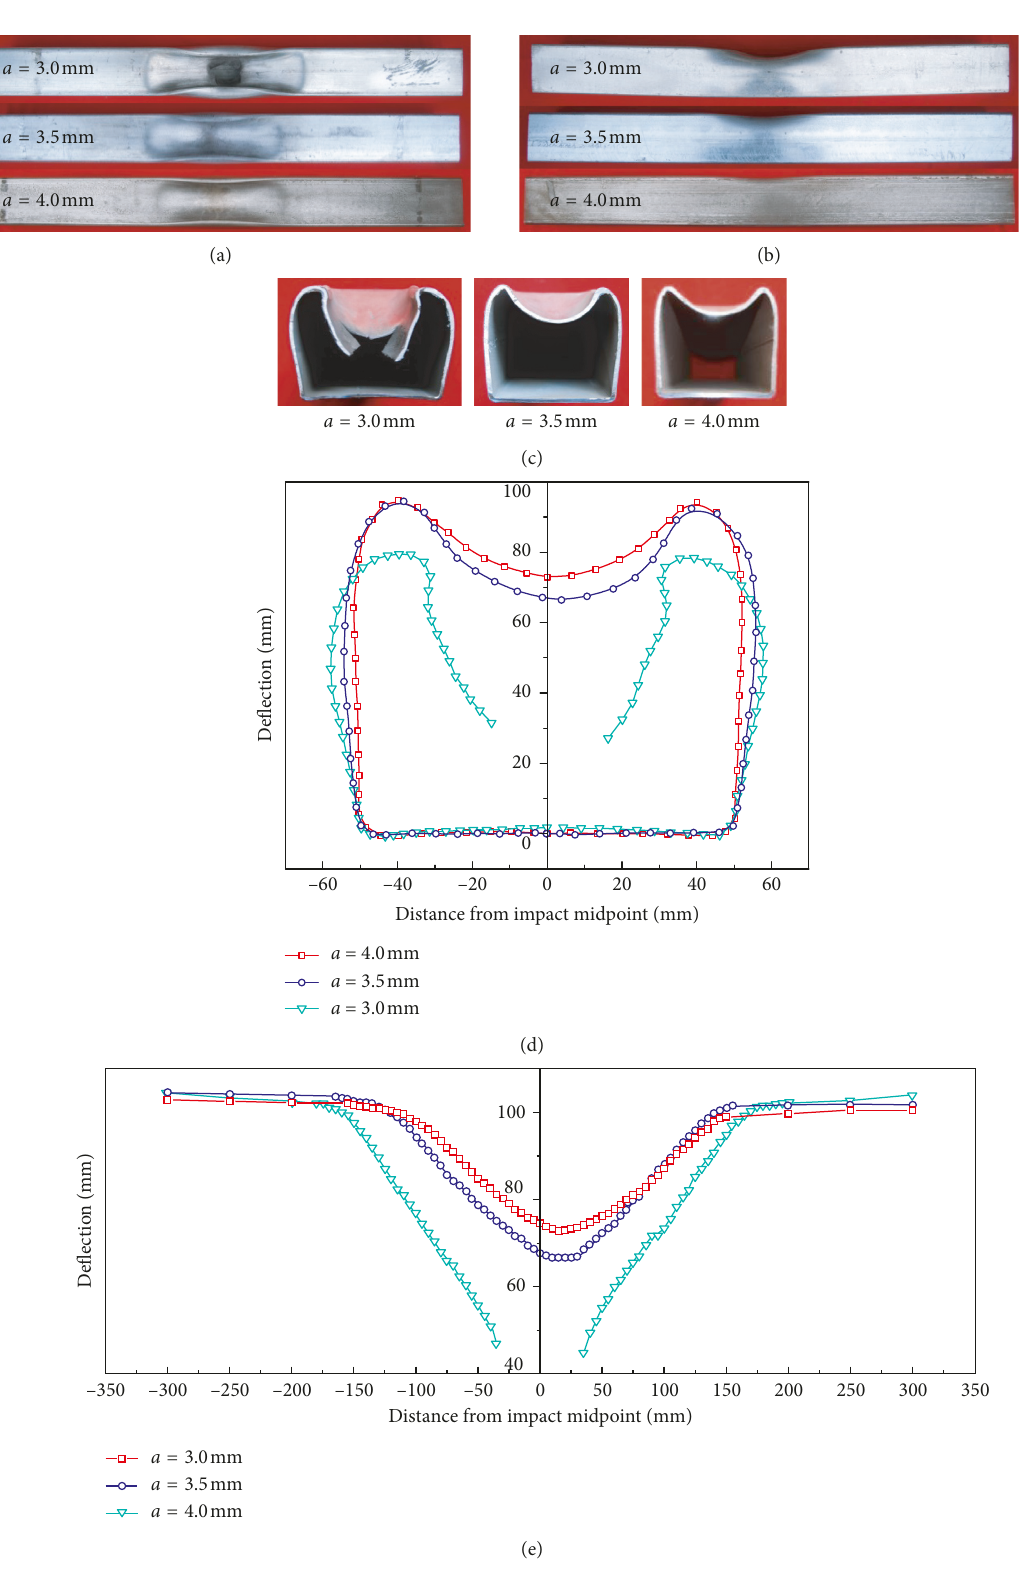
Figure 15: Damage of square tubes with different thicknesses at a stand-off distance of 18cm. (a) Planform view. (b) Side view. (c) Cross section. (d) Deformation curve on cross section. (e) Deflection in axial